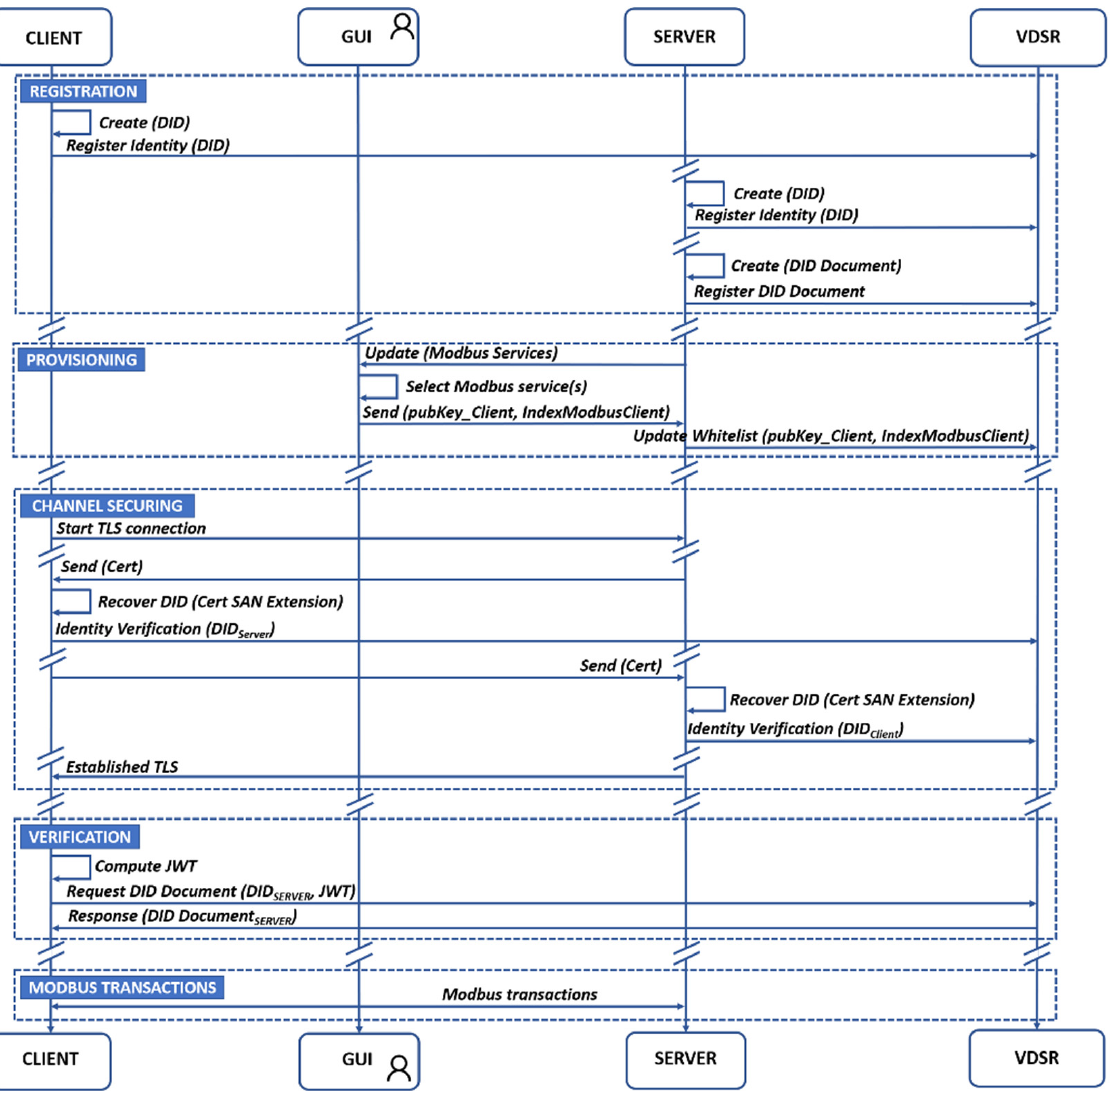
Figure 3. Interaction between entities and information processing by VDSR.